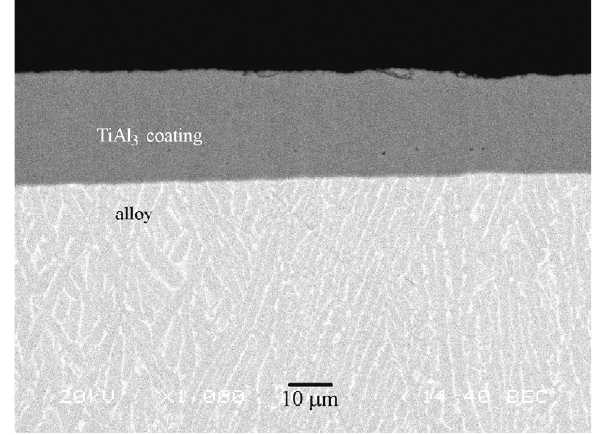
Figure 2. Micrograph of cross-section of the coating/TA15.